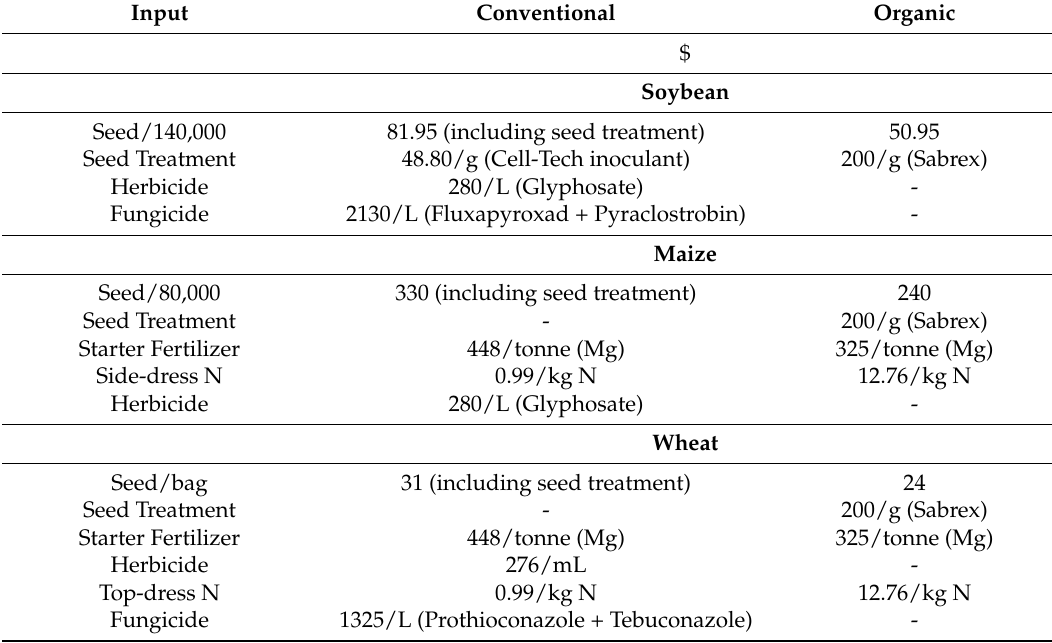
Table 2. Costs of variable inputs, including seed, hopper seed treatments, (inoculant for conventional soybean and Sabrex for organic crops), starter fertilizer, N fertilizer, herbicide, and fungicide in conventional and/or organic soybean, maize, and